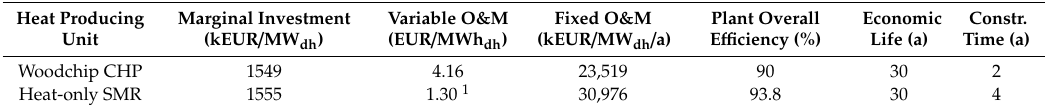
Table 3. Variable and fixed costs for simulated CHP and SMR units